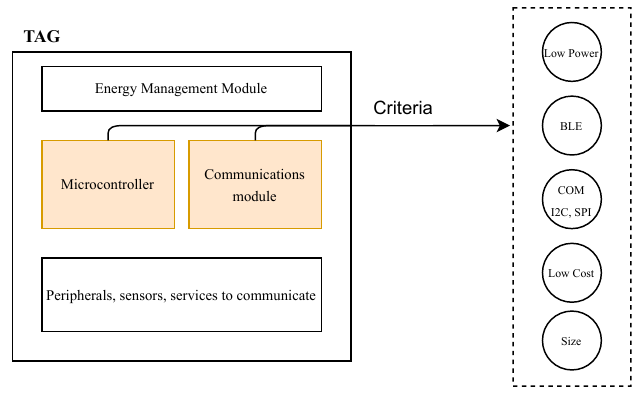
Figure 6. General concept of the TAG device (taken from